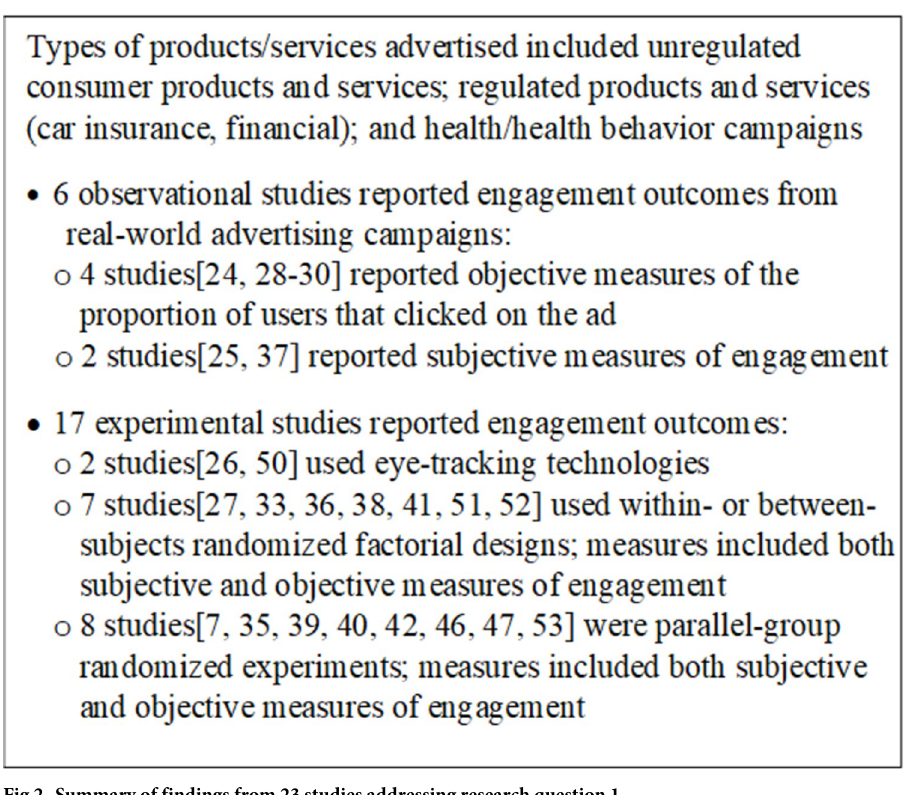
Fig 2. Summary of findings from 23 studies addressing research question